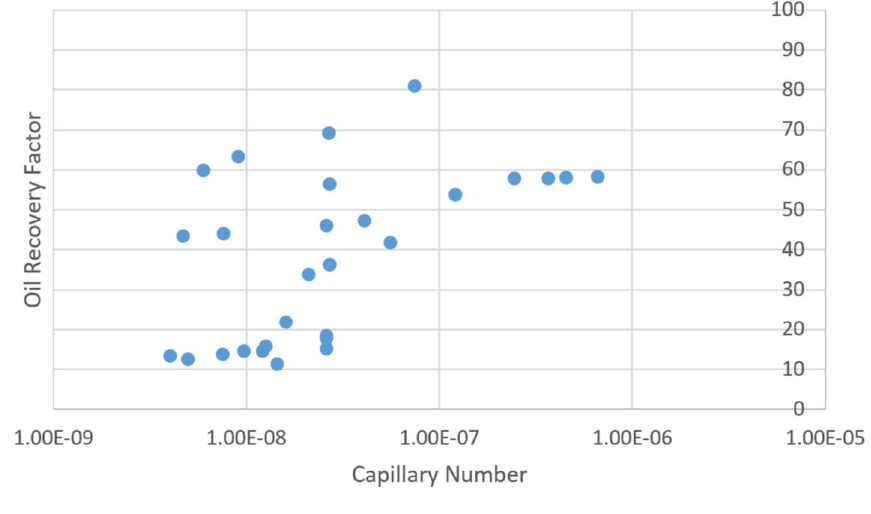
Fig. 1 Capillary number of CO core-flooding tests